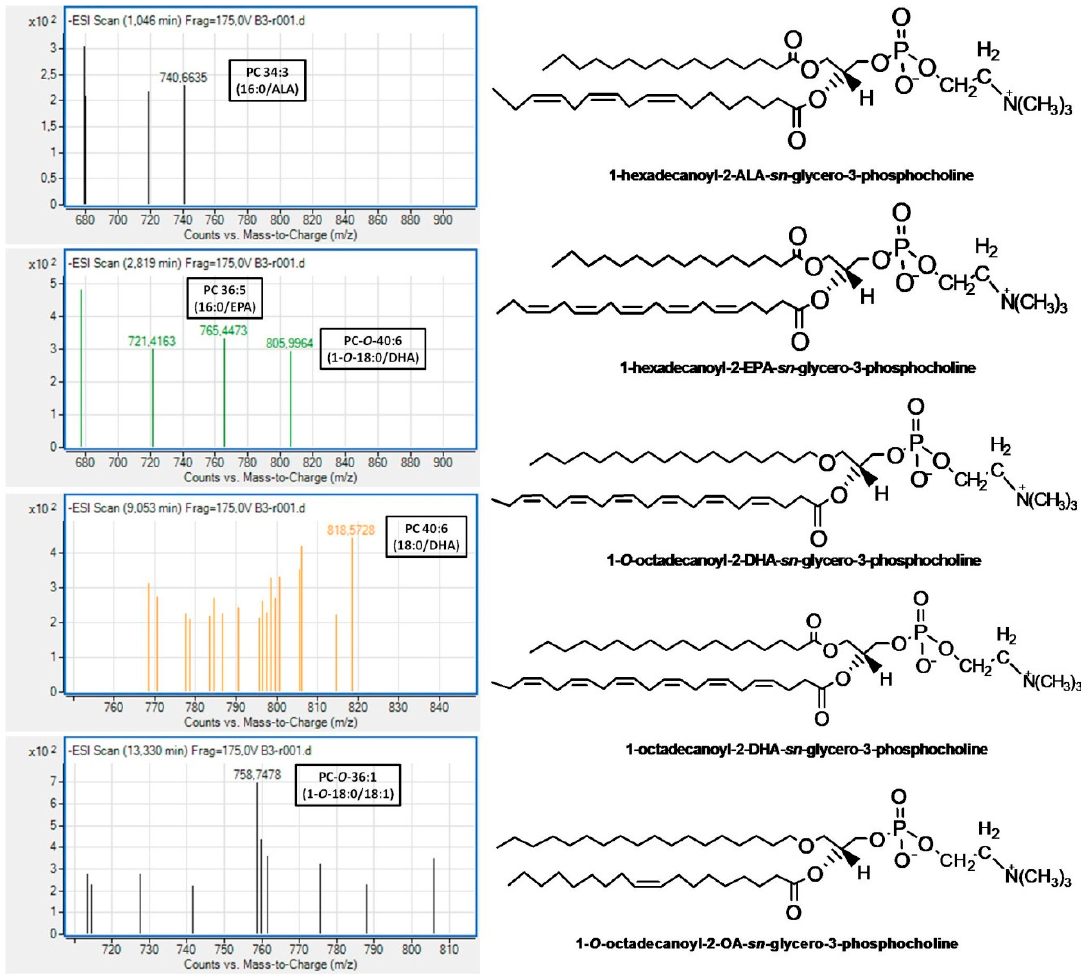
Figure 2. Representative mass spectra and structures of the bioactive PC molecules identified in the PC subclass of Irish ale. PC = phosphatidylcholine; ALA = α -linolenic acid (18:3 n-3); EPA = eicosapentaenoic acid (20:5 n-3); DHA = docosahexaenoic acid (22:6 n-3); and OA = oleic acid.